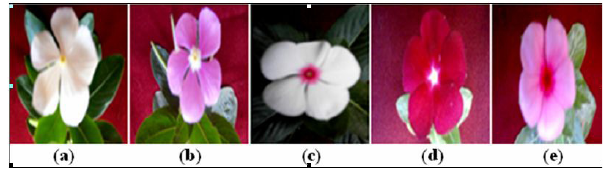
Fig. 1. Photographs of flowers of the five cultivars of Catharan- thus roseus (L.) G. Don.: a) ‘Patricia’ white possessing white petal with small yellow center; b) ‘Cooler orchid’ consisting pinkish red petal with white eye with yellow; c) ‘Cooler peppermint’ im- proved shows white petal with small red eye with yellow centre; d) ‘First kiss coral’ displayed crimson red petal with large white eye and e) Experimental rose pink with eyes represented pale pink petal with radiating red eye Isozyme analysis Three young leaves were taken in an ice bucket from 3 plants per cultivar. A mixed sample of all leaves per culti- var was used for